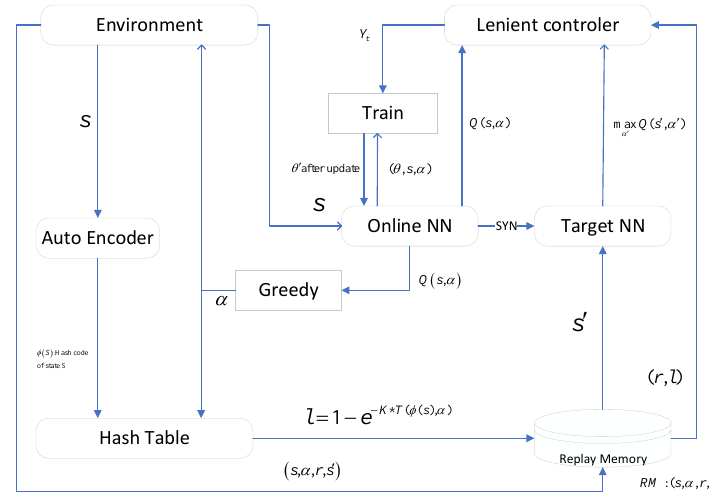
Figure 3. Process of LC-MARL.